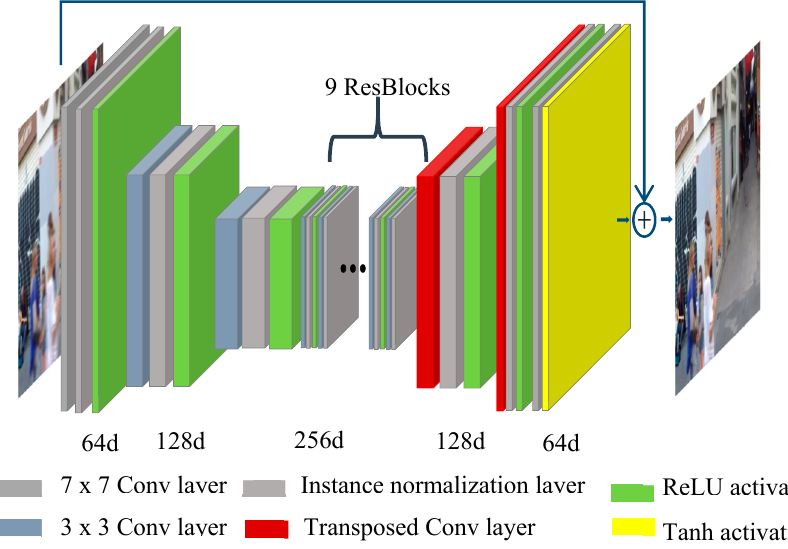
Figure 12. Architecture of generator in WGAN-GP.